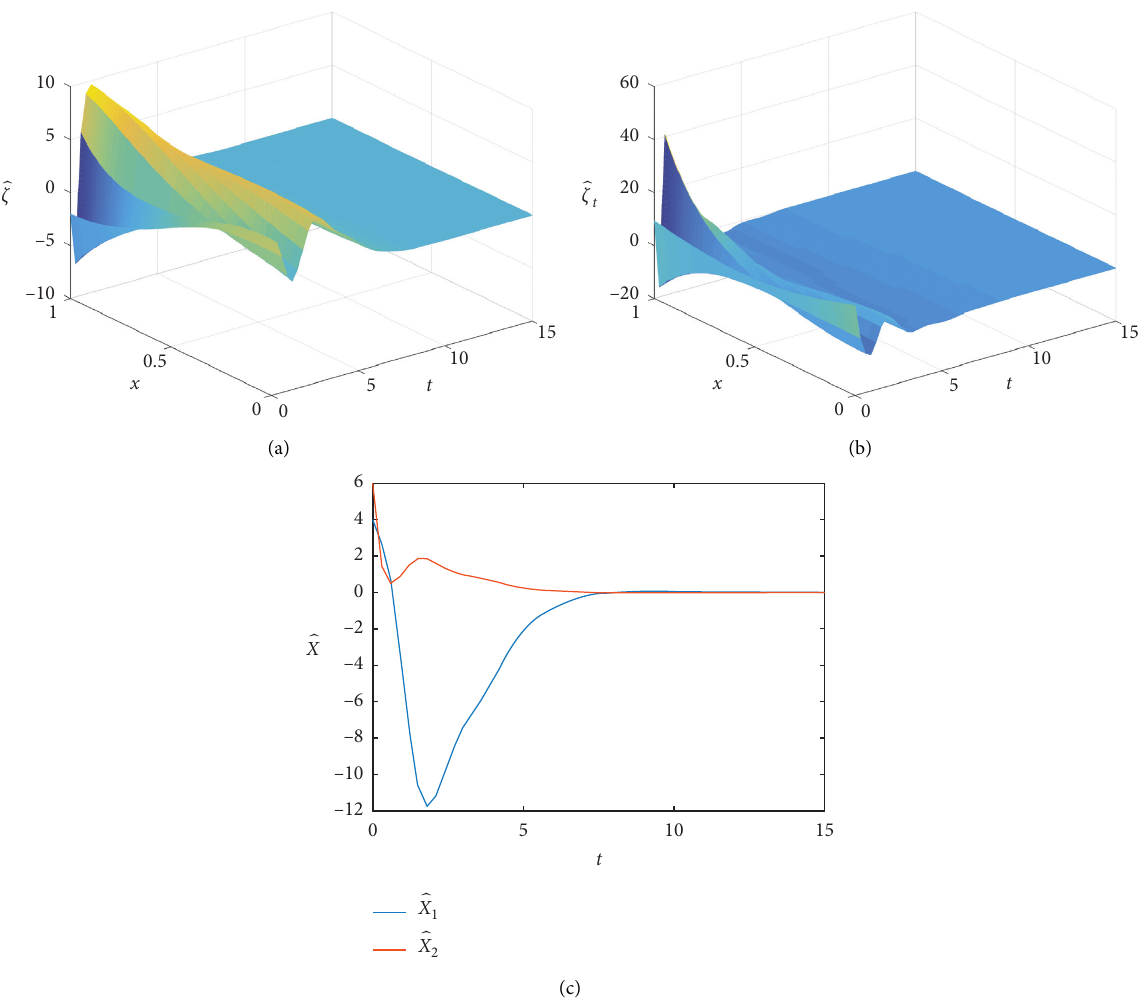
Figure 2: Solution of “ ( 􏽢 X, 􏽢 ζ , 􏽢 ζ ) part” in the closed-loop system (58). (a) Displacement of the 􏽢 ς -part. (b) Velocity of the 􏽢 ς -part. (c) 􏽢 X t